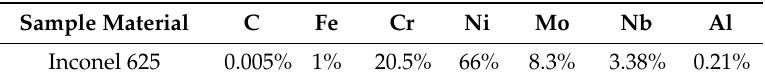
Table 3. Chemical composition of Inconel 625, raw material prior to